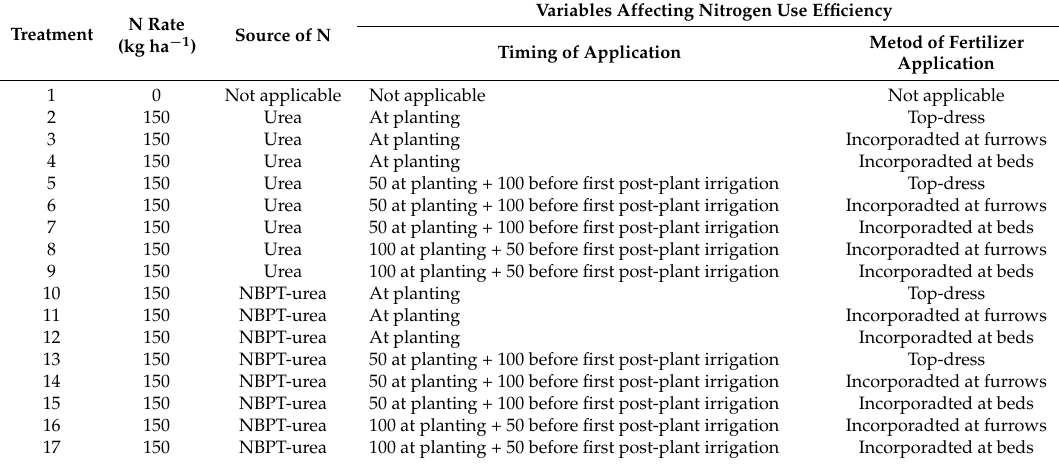
Table 2. N management practices that included treatments composed of urea sources, timing, and methods of fertilizer application at the International Maize and Wheat Improvement Center (CIMMYT), in the Yaqui valley, near Ciudad Obregon, Sonora,